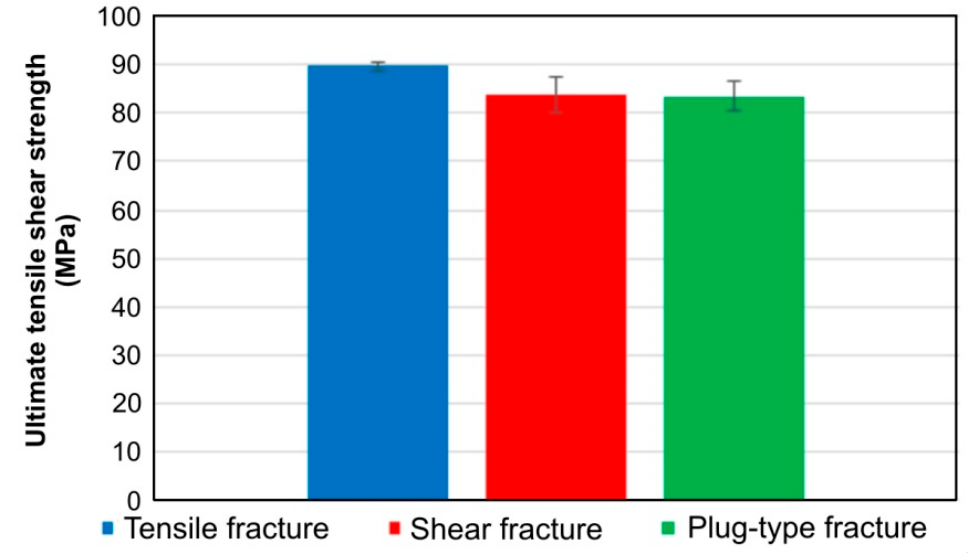
Figure 11. Ultimate tensile shear strength corresponding to specific fracture modes.